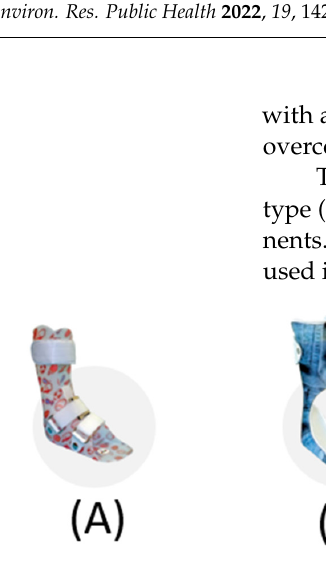
Figure 1. ( A ) solid ankle foot orthosis (sAFO), ( B ) ground reaction AFO (GRAFO), ( C ) hinged AFO (hAFO) ( D ) posterior leaf spring AFO (PLS), ( E ) carbon modular orthosis (CaMO).